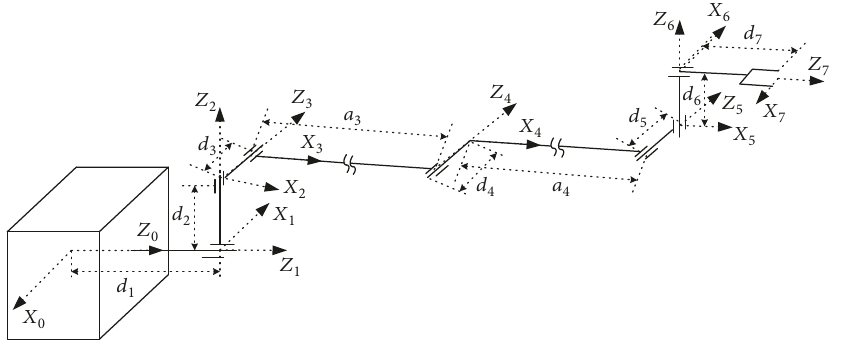
Figure 2: SSRMS-type 7 DOF space manipulator. Table 1: Kinematic parameters of SSRMS-type 7 DOF space manipulator.